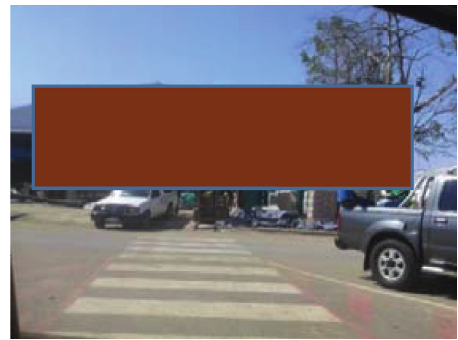
Figure 1: Bhejani Hardware and Furniture: site one.